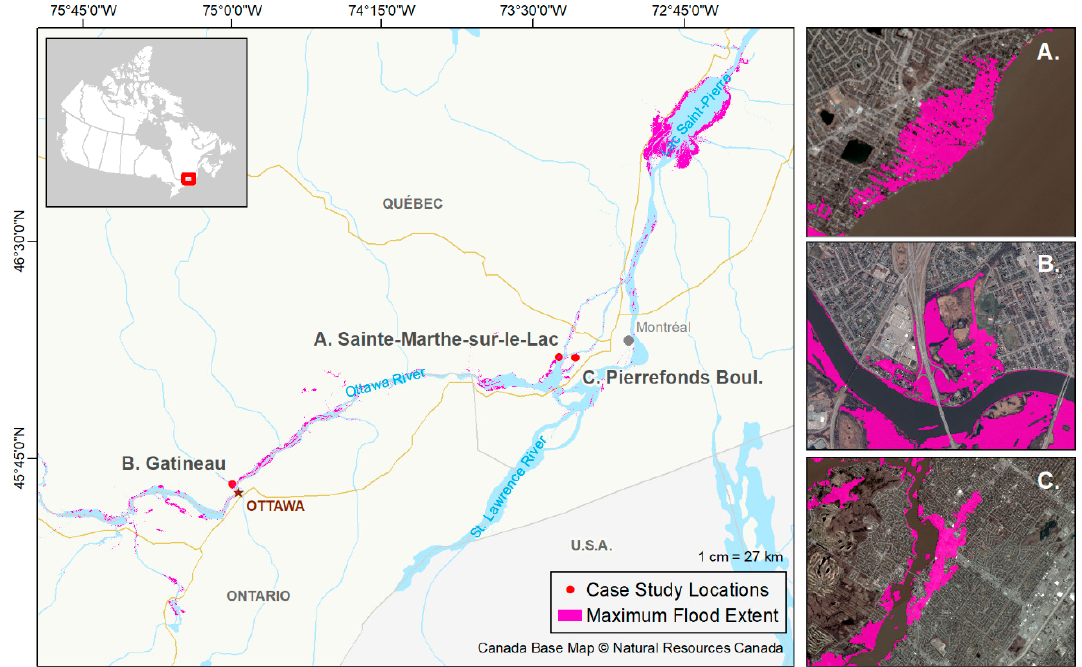
Figure 3. The 2019 maximum flood extent product generated from a combination of PlanetScope and RapidEye optical imagery acquired near peak-flood ( main panel ) with flood extents of the three study areas over Sainte-Marthe in 2019, and Gatineau and Pierrefonds in 2017 ( right panels ).